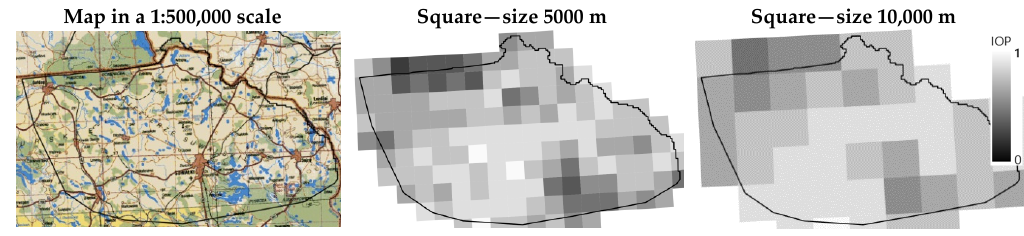
Figure 14. Fragments of passability maps generated for the largest cells in the whole test area.